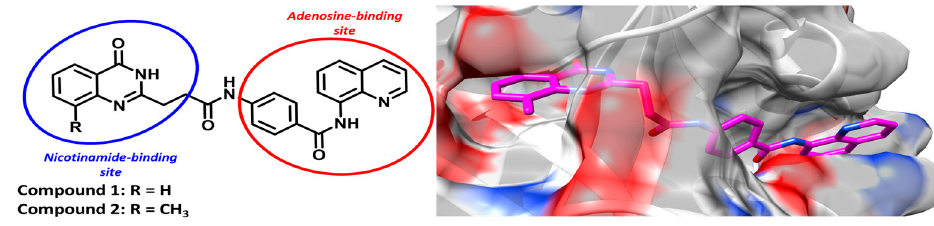
Figure 1. Proposed pathway for CYP activation of duocarmycin biopersursor substrates 3,4 (A = pyrrole or furan